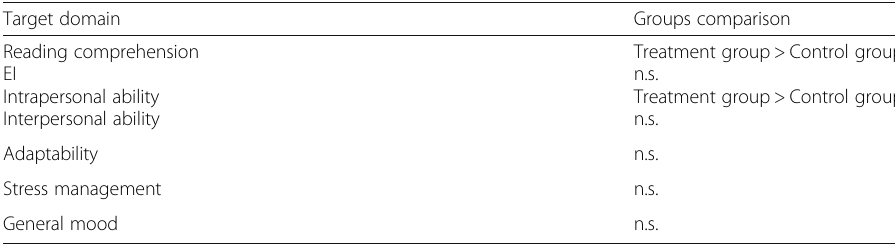
Table 6 Summary of the results Target domain Groups